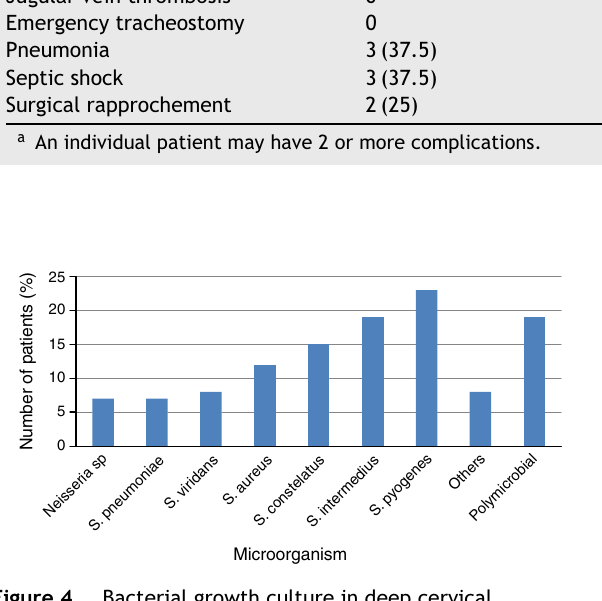
Figure 4 Bacterial growth culture in deep cervical